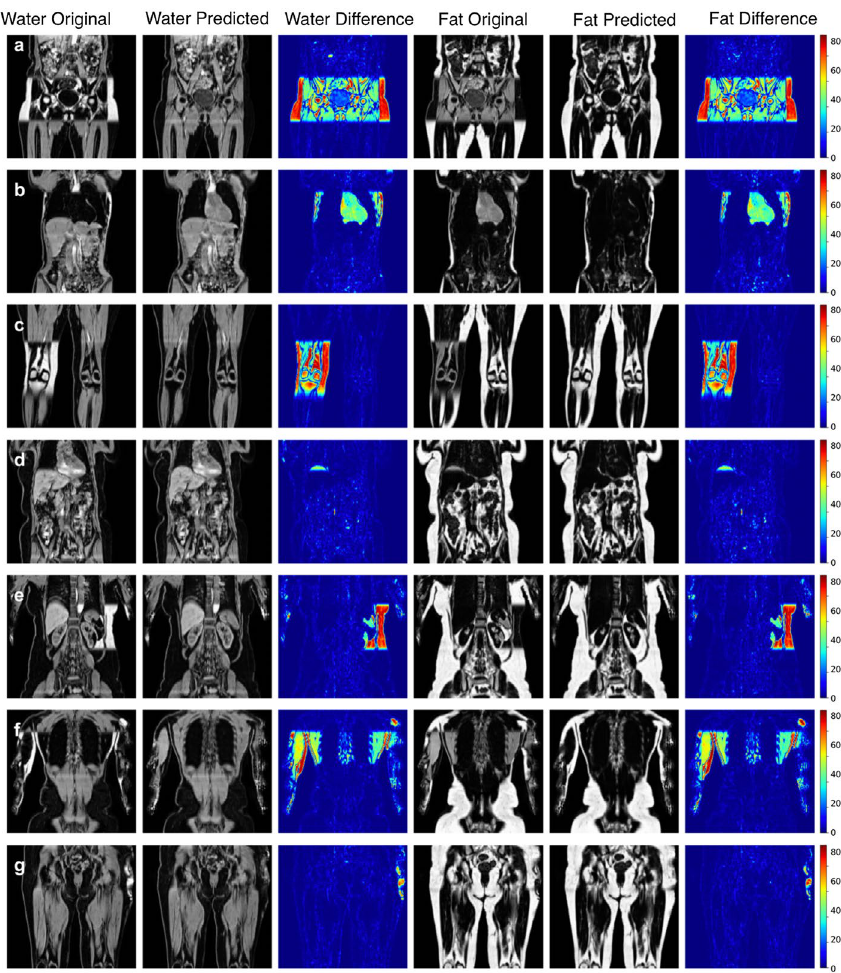
Fig. 4 Model predictions where the original separated fat and water signals contained swaps: a full swap of the fourth series, b partial swap in second series, c swap in one leg, d swap at the top of the liver, e complex partial swap in the kidneys, spleen, and subcutaneous fat, f complex partial swap in the back and arm muscles at the edge of the field of view and g a partial swap at the extremities of the body due to inhomogeneities in the magnetic field at the boundary. Absolute differences are displayed in the original image